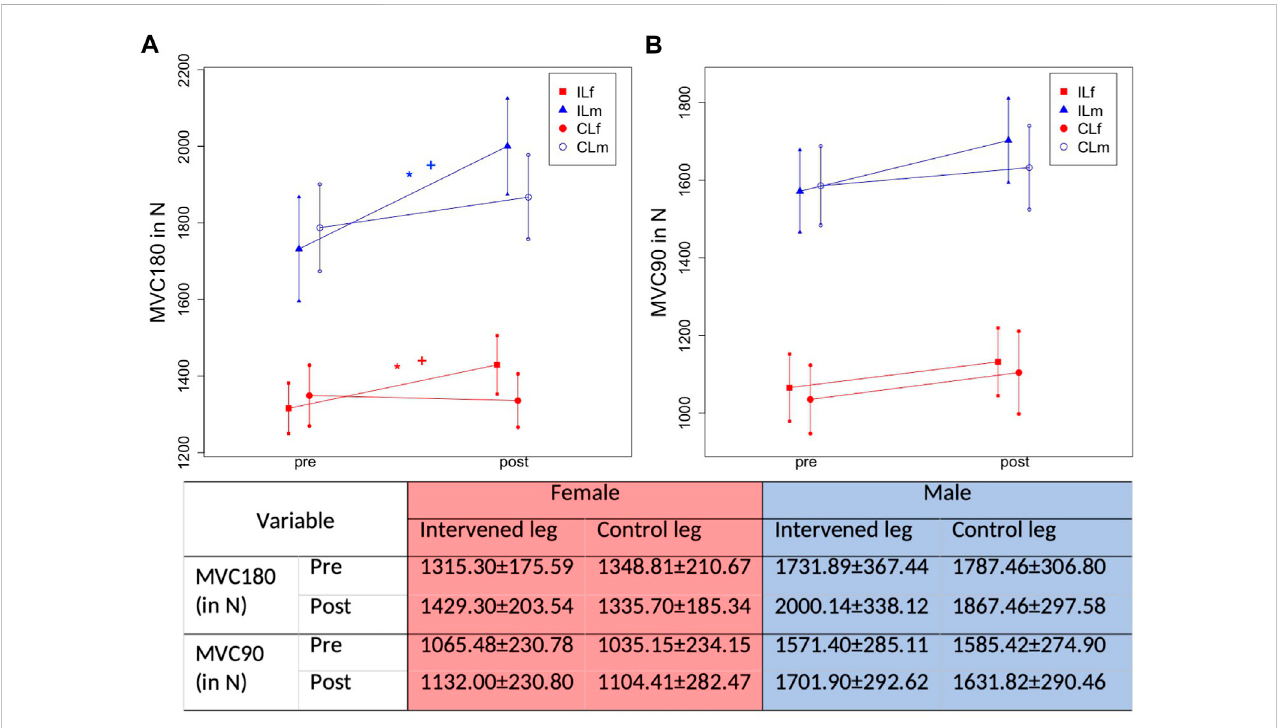
FIGURE 5 Graphical illustration of progression in ROM in IL and CL due to 1-h daily stretching training in plantar fl exor in MVC180 (Maximal strength testing with extended knee joint) (A) and MVC90 (Maximal strength testing with bent knee joint) (B) considering sex. The * illustrates a signi fi cant difference to the control leg, the + illustrates a signi fi cant difference to the other sex.